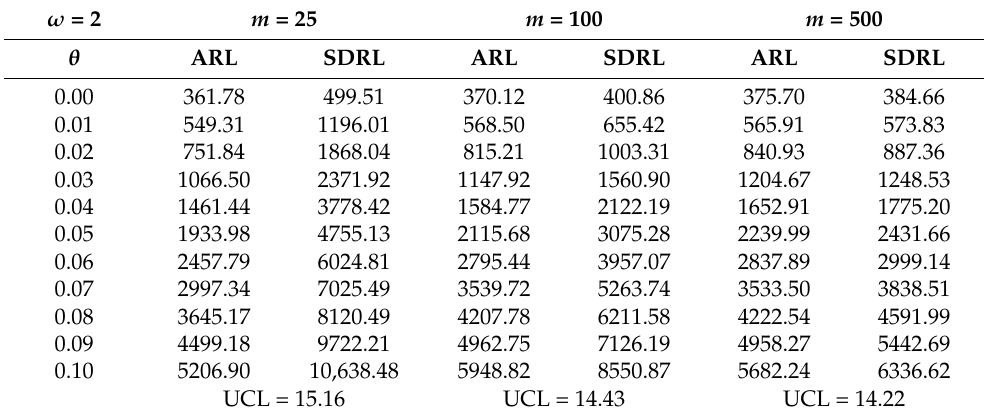
Table 6. ARL 0 and SDRL 0 values of the proposed SDRE multivariate Shewhart control chart ( ω =